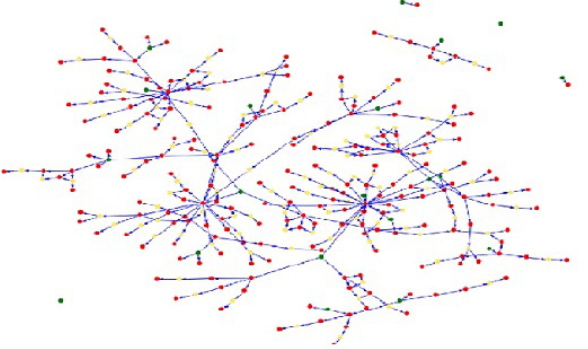
Figure 7: Complex network of coffee transcripts constructed on RDF associations from transcript annotations. Green: Contig annotation; Yellow: Relational Concept; Red: Annotation concept